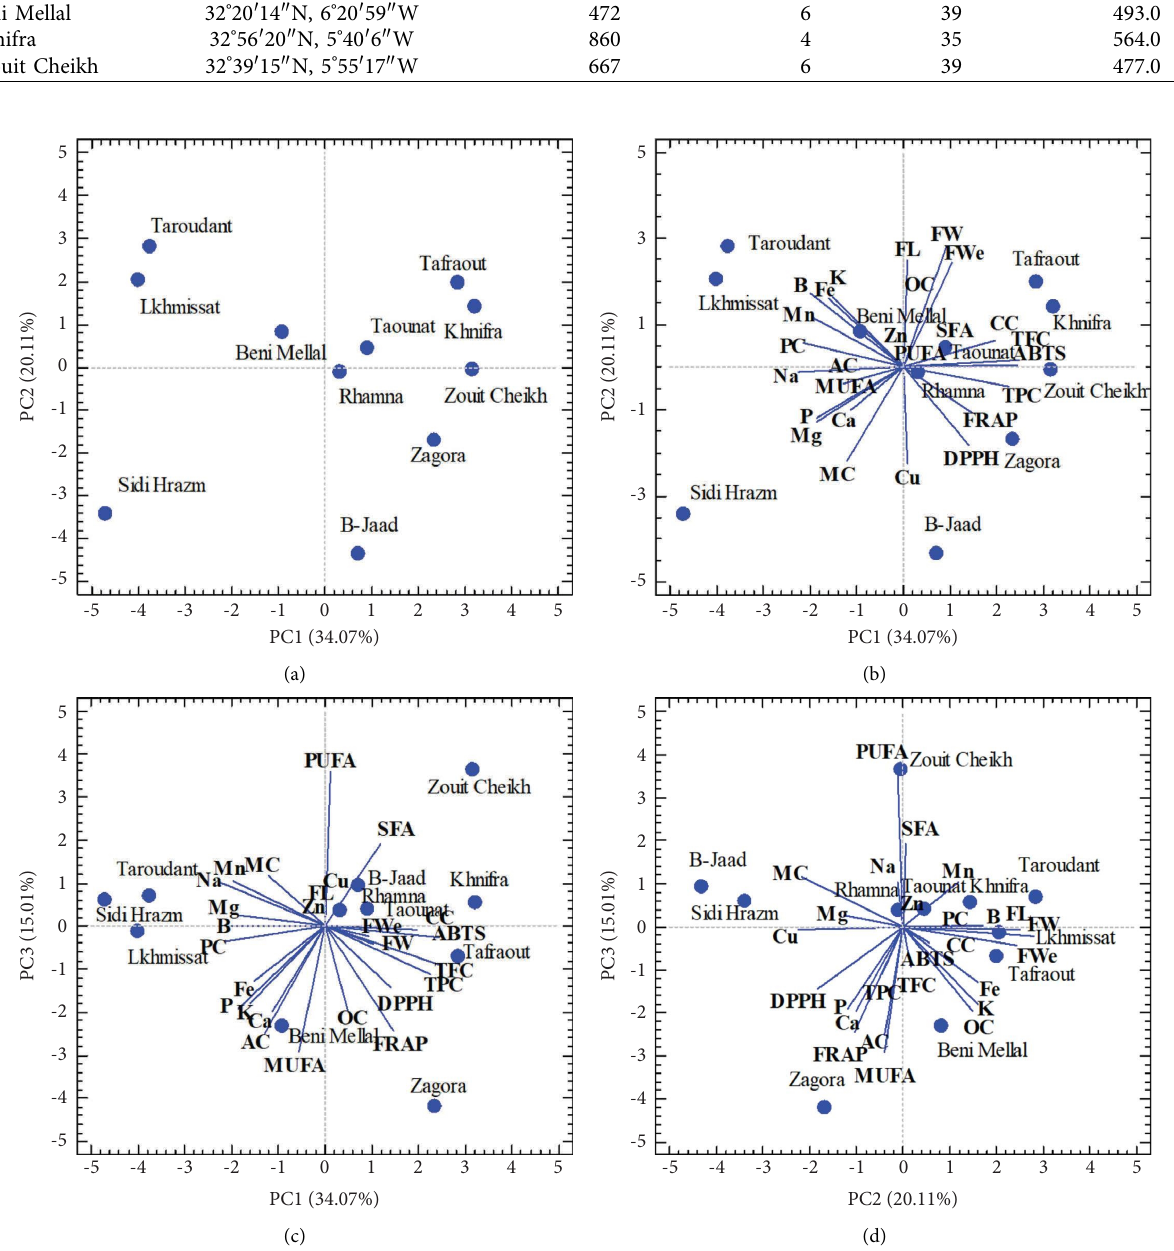
Figure 2 : Principal component (PC) projections for the frst three PCs that most impact infuenced fruit traits. Blue segments represent dependent variables, while points plotted are mean values. FWe � weight, FL � fruit length, KW � fruit width, OC � oil content, CC � carbohydrates content, PC � protein content, AC � ash content, and MC � moisture